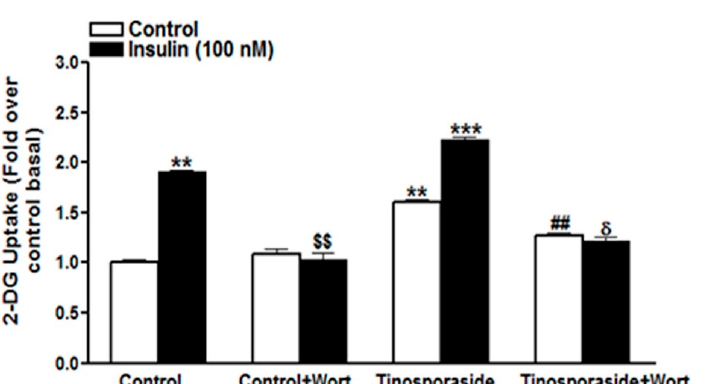
Figure 4. Effect of wortmannin on tinosporaside-induced glucose uptake in L6 myotubes: Cells were incubated in the absence (Control) or the presence of tinosporaside (10 μ M) for 16 h without or with wortmannin (100 nM). After incubation, myotubes were left untreated (white bars) or stimulated with 100 nM insulin (black bars) for 20 min, which was followed by the determination of the glucose uptake. Results are expressed as fold stimulation over control basal and performed in triplicate. Results shown are mean ± SE of three independent experiments. ** p < 0.01, *** p < 0.001, relative to control basal; $$ p < 0.01, relative to control insulin-treated group; ## p < 0.01, relative to basal tino- sporaside-treated group; δ p < 0.05 relative to tinosporaside insulin-treated group. 2.4. Effect of Compound C on Tinosporaside-Stimulated Glucose Uptake in L6 Myotubes Activation of AMPK has been known to contribute to an increase in glucose uptake and utilization in L6 myotubes [21]. Hence, to investigate the effect of tinosporaside on the activation of the AMPK pathway, we treated the L6 cells with tinosporaside in the